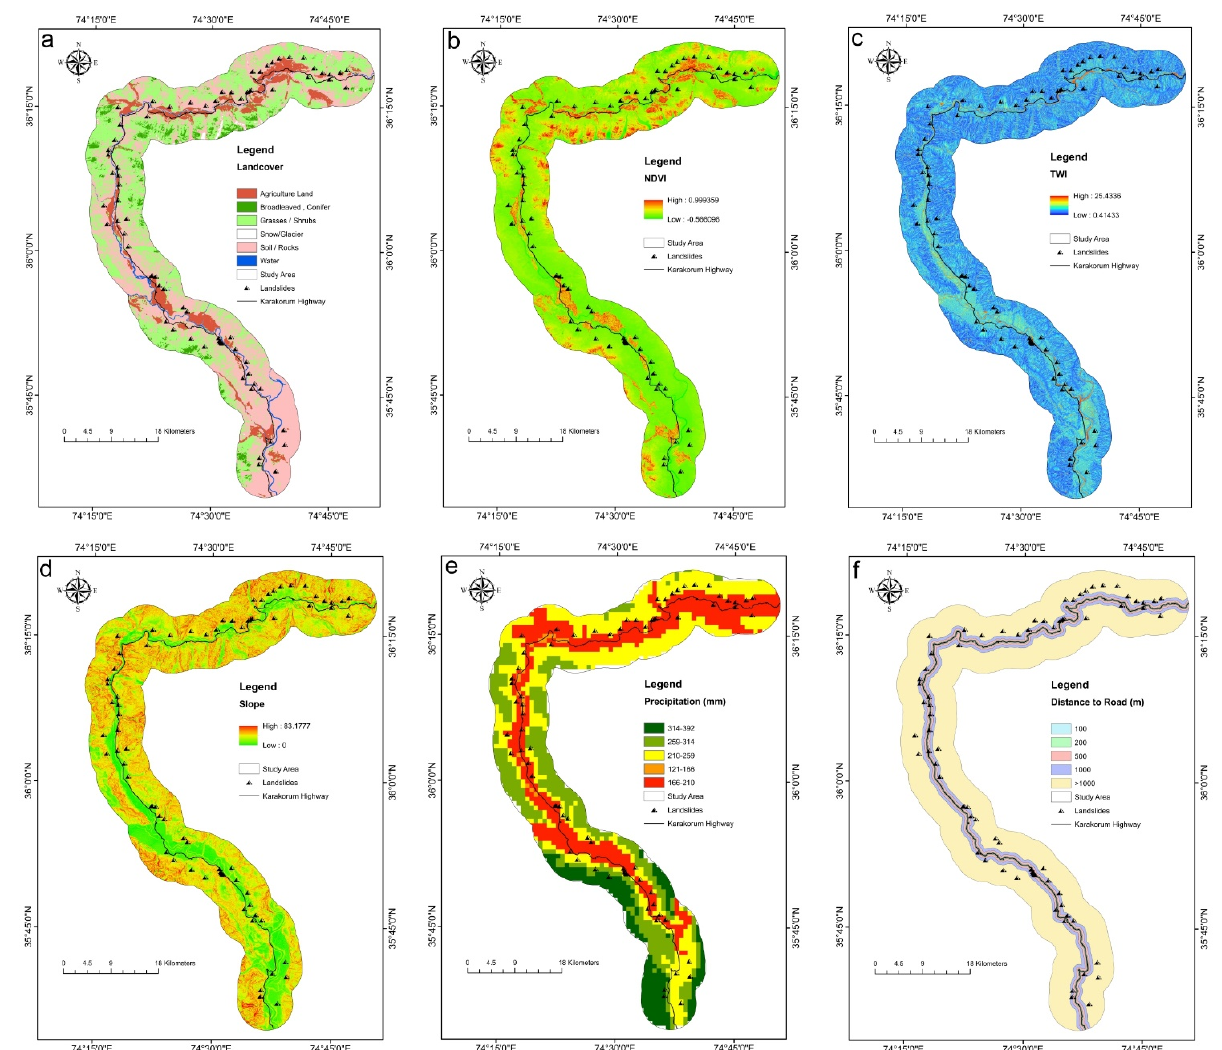
Figure 6. Landslide factors. ( a ) Landcover, ( b ) NDVI, ( c ) TWI, ( d ) slope, ( e ) precipitation, ( f ) distance to road.